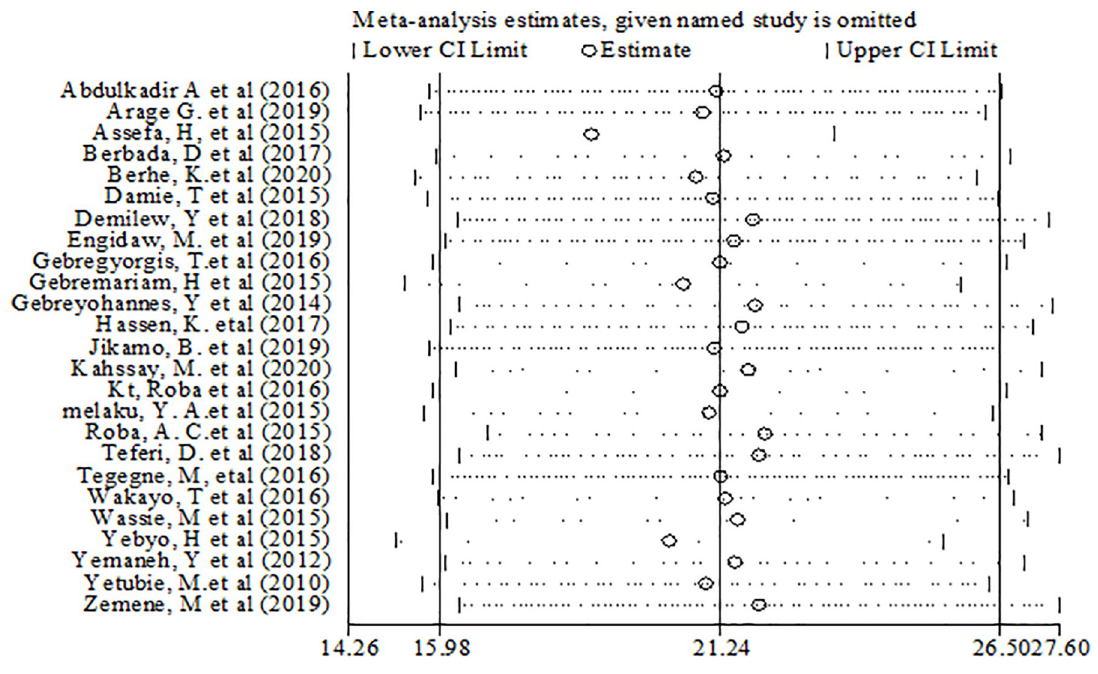
Fig 6. Sensitivity analysis of thinness among adolescents in Ethiopia.